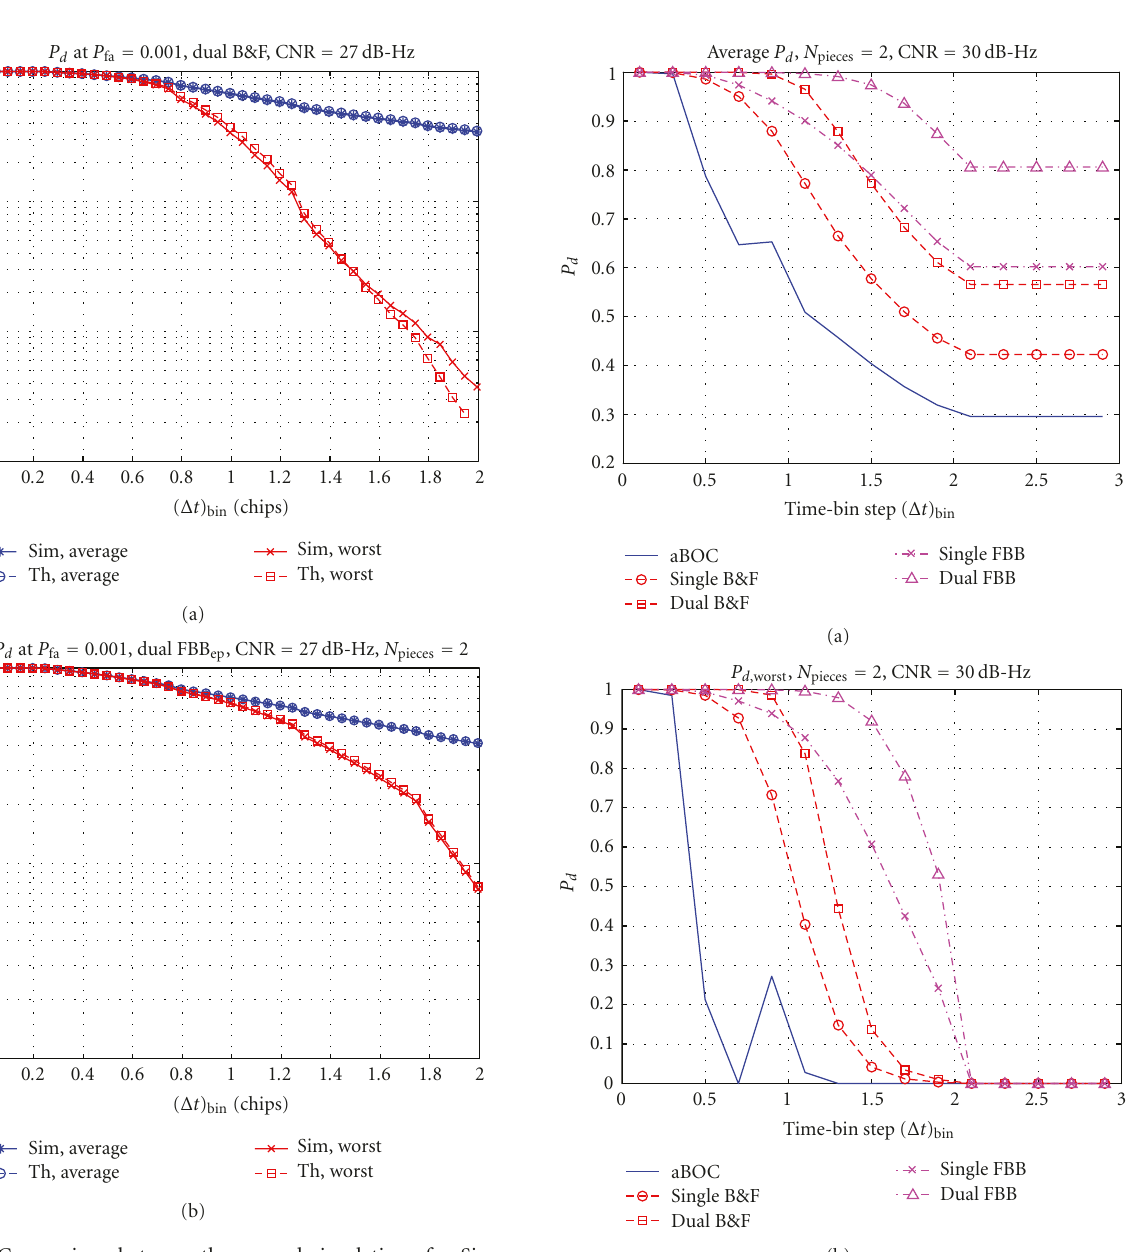
Figure 7: Comparison between theory and simulations for Sin- BOC(1,1). Left: dual-sideband B&F method. Right: Dual-sideband FBB ep method, N pieces = 2. N c = 10 milliseconds, N nc = 5, CNR = 27 dB-Hz, N s = 5.